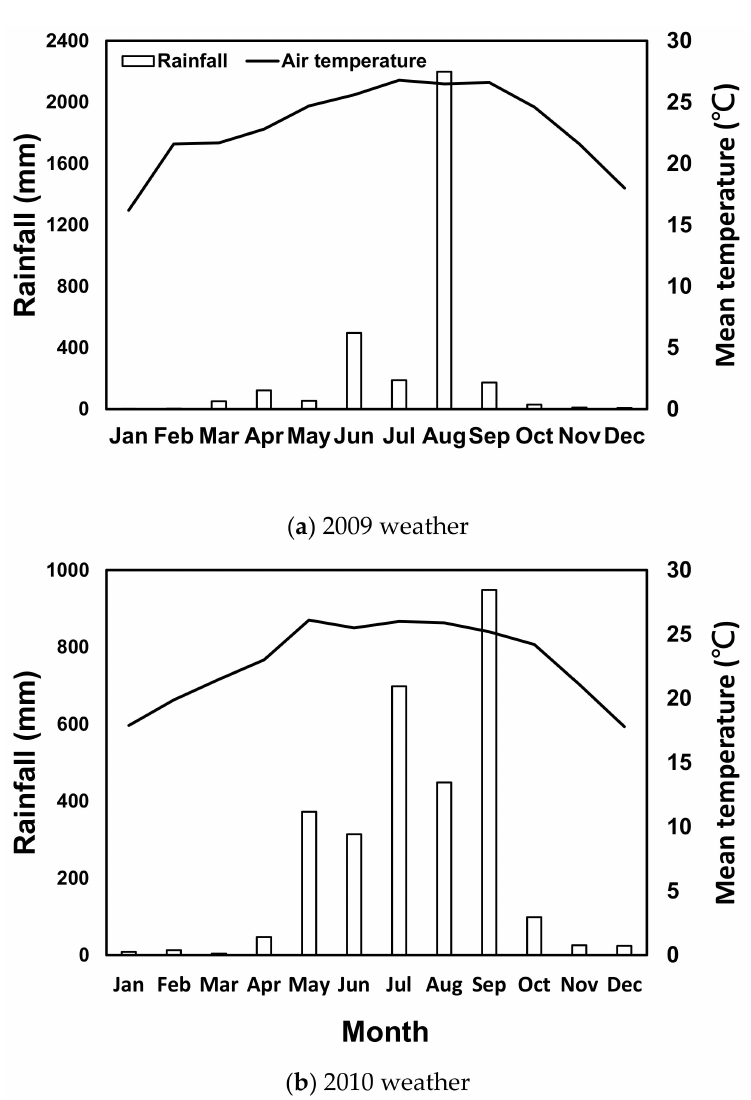
Figure A1. The monthly mean temperature and accumulated rainfall of the Jiasian weather station (in the middle reach of the Kaoping River) in ( a ) 2009 and ( b ) 2010. Data source: Taiwan Central Weather